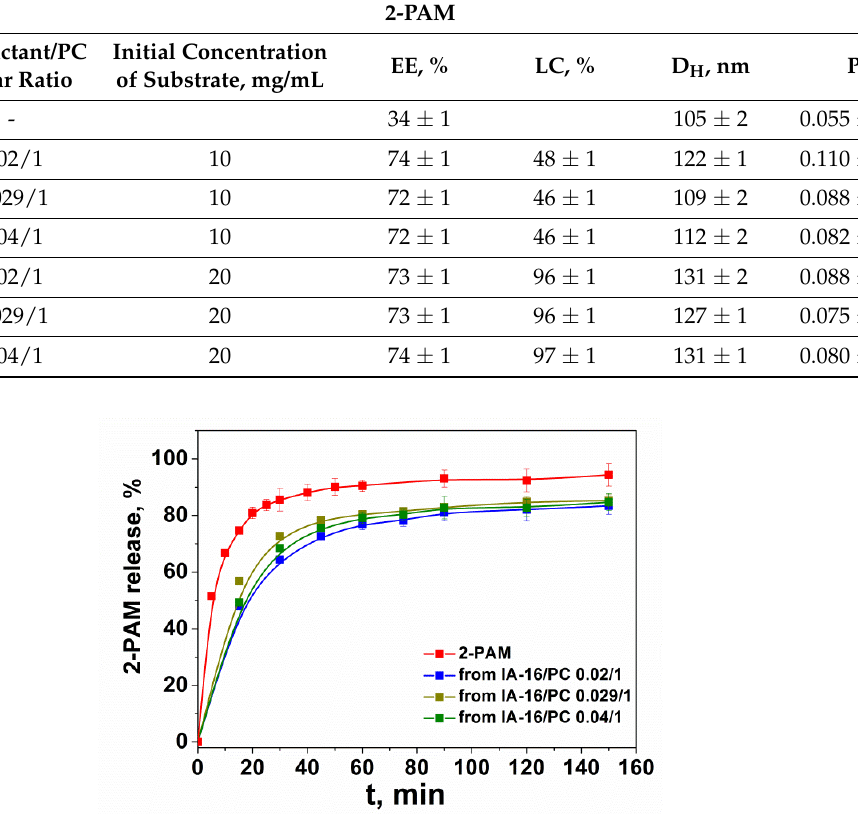
Figure 5. In vitro 2-PAM release from IA-16/PC modified liposomes using the dialysis bag method ( n = 3); C (2-PAM) = 10 mg/mL, phosphate buffer (0.025 M), pH = 7.4, 37 °C. Table 4. Evaluation of the hemolytic activity of IA-16/PC liposomal system (surfactant/lipid molar ratio of 0.029/1) loaded with 2-PAM (C = 10